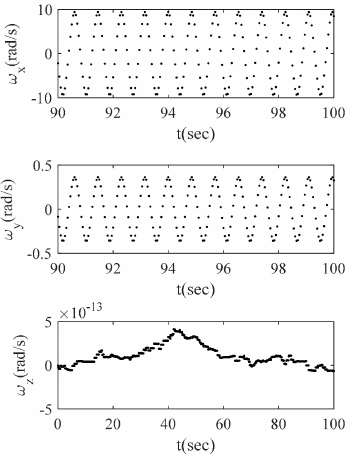
Figure 18. The simulation results of angular velocity.